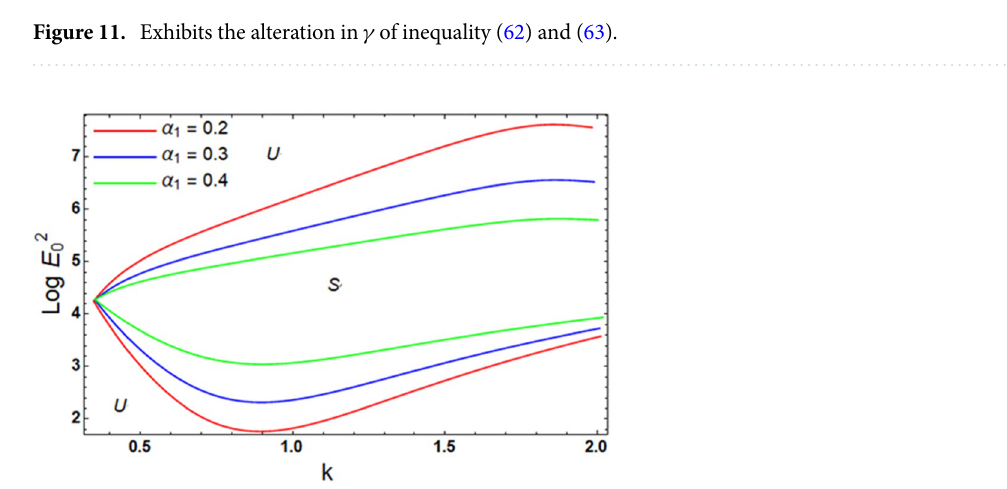
Figure 12 examines the stability scheme for distinct amounts of heat transference factor α 1 . It is indicated that the stable zone is diminished by the increase of α 1 . Thence, it is exhibited that the transfer of heat as well as mass transfer brings about a destabilizing impact. The increase in MHT through the boundary can transmit further heat.